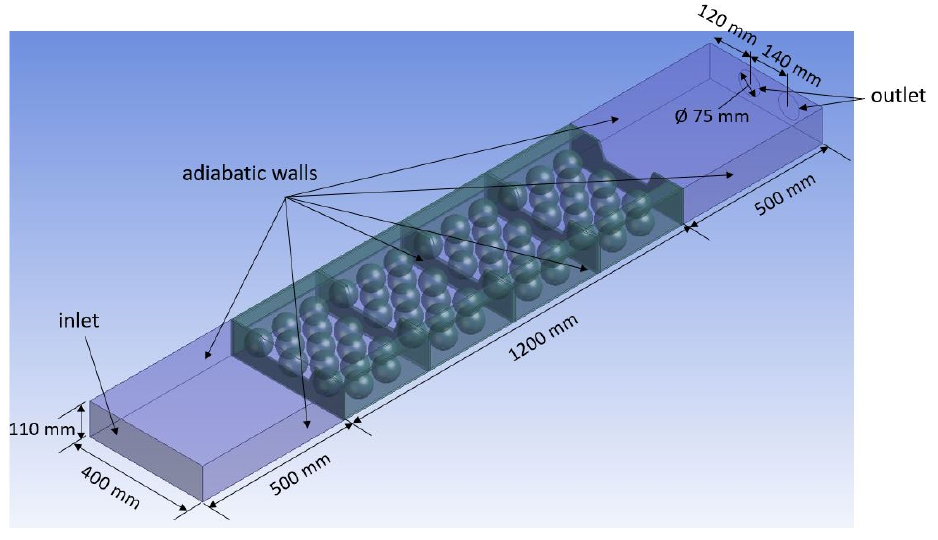
Figure 4. CFD model boundary